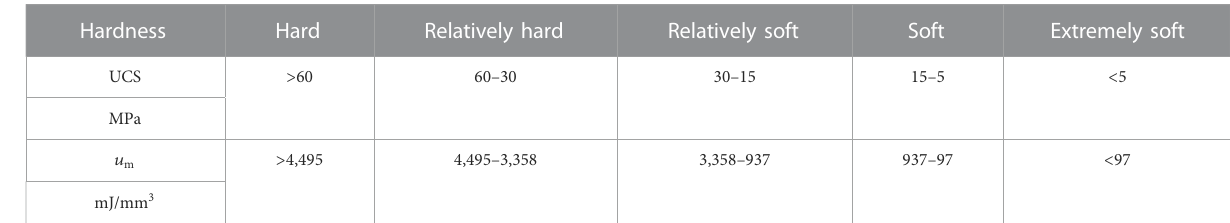
TABLE 6 Drilling speci fi c energy - rock hardness evaluation criteria [3 . 3] .